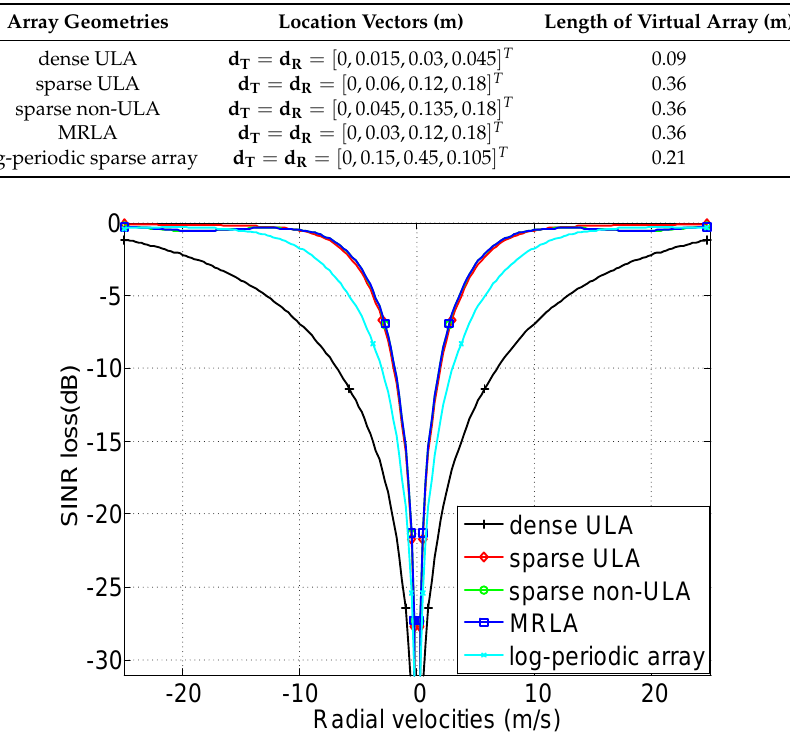
Figure 6. SINR loss of MIMO GMTI radar with different array